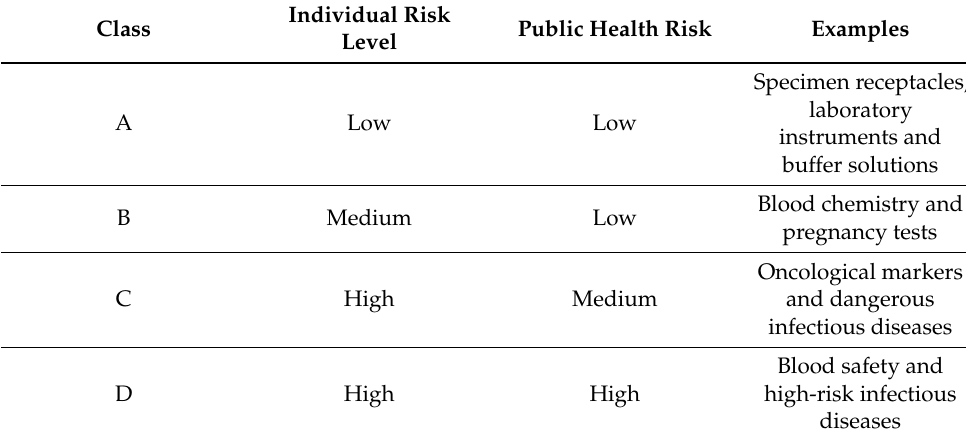
Table 2. In vitro medical device classification according to IVDR. Individual Risk Class Public Health Risk Level